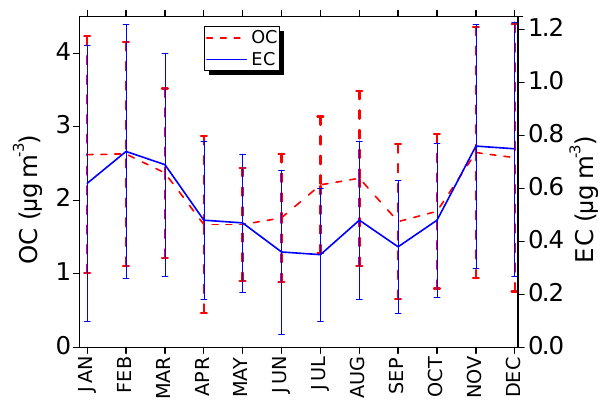
summer and winter changes in EC emissions, as related